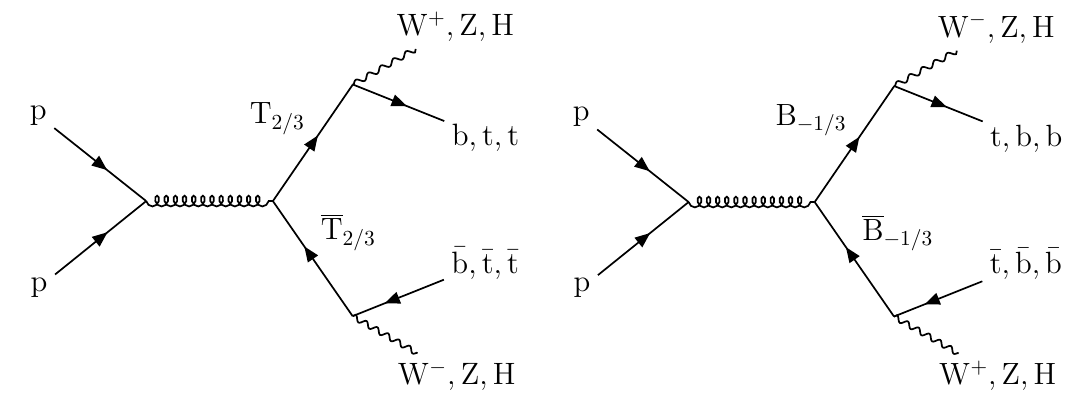
Figure 1 . Leading order Feynman diagrams showing pair production and decays of TT (left) and BB